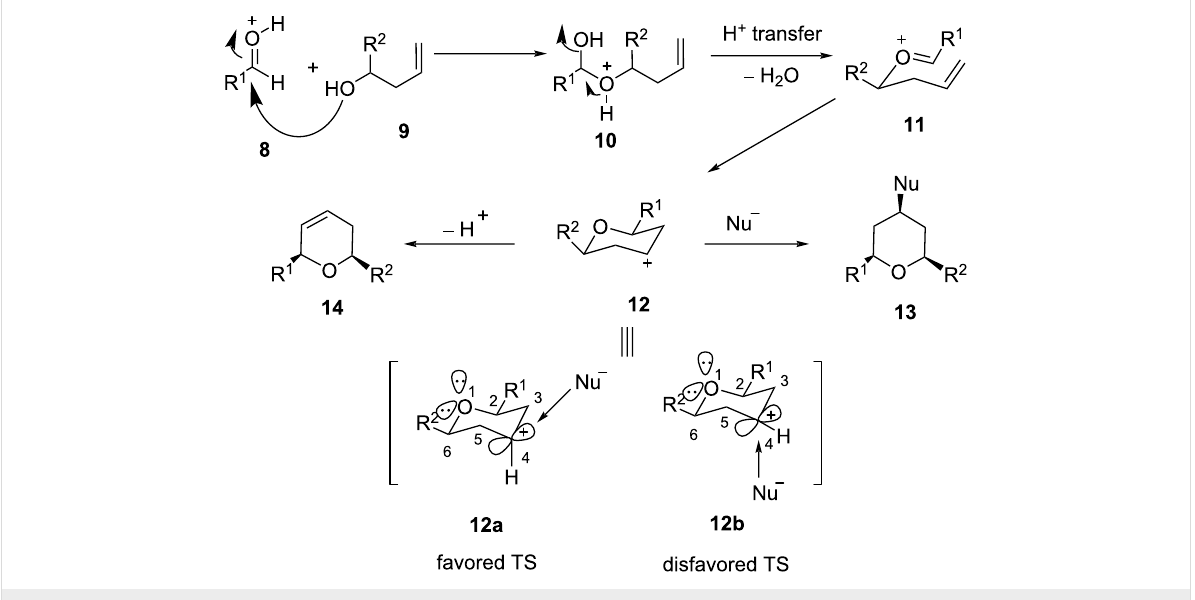
Scheme 3: General stereochemical outcome of the Prins